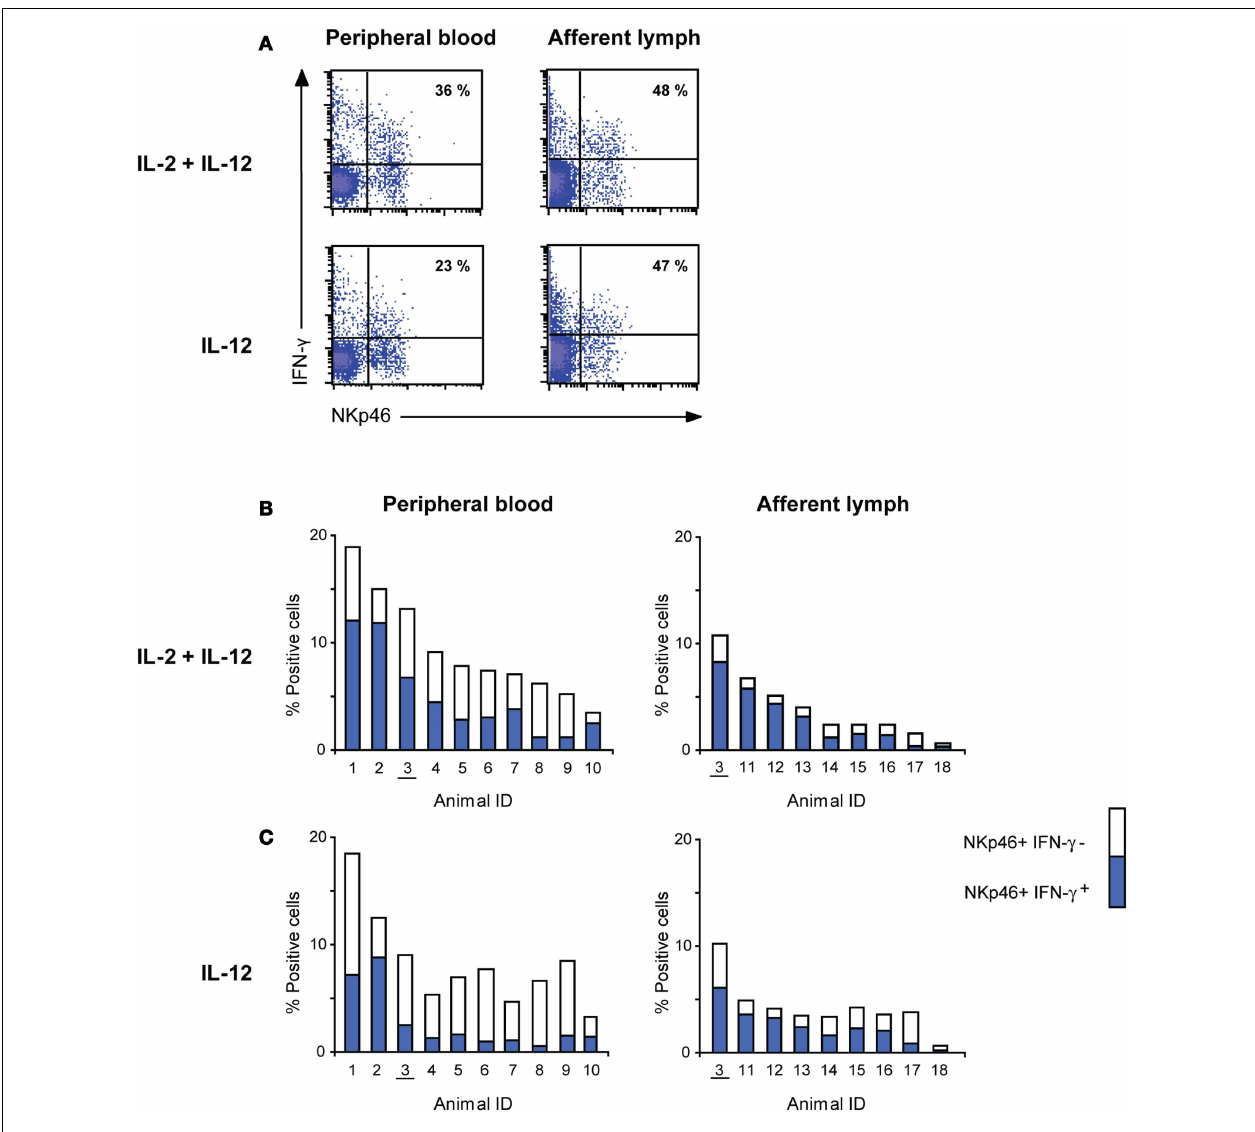
following cytokine stimulation as in A with IL-2 and IL-12 or only IL-12. Complete columns represent the total percentage of NKp46 + cells in the mononuclear cell fraction, while the inner blue columns indicate the percentage of NKp46 + IFN- γ + cells in the same fraction. All individual animals are presented with a unique ID, where numbers 1–10 are Norwegian Red and 11–18 are Holstein–Friesian. One paired NRF calf is